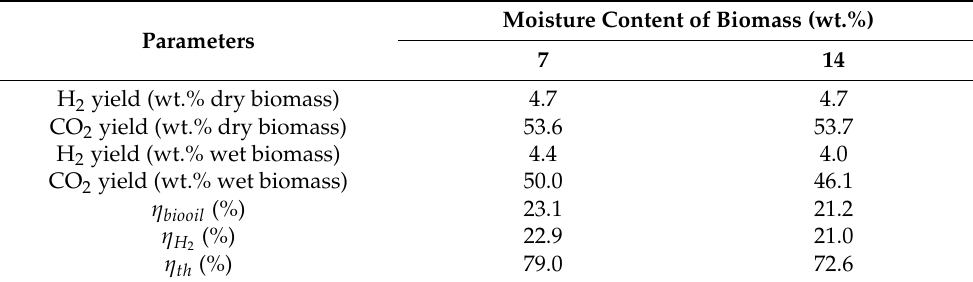
Table 8. Product yields and efficiencies of Scheme 2 with different moisture contents of biomass and bio-oil condenser temperature of 50 ◦